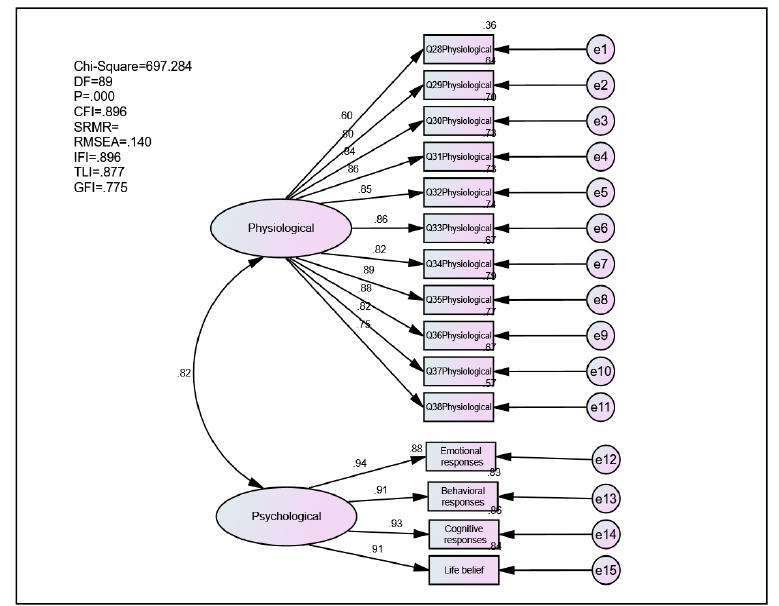
Figure 3 . The initial measurement model. Figure 3. The initial measurement model.